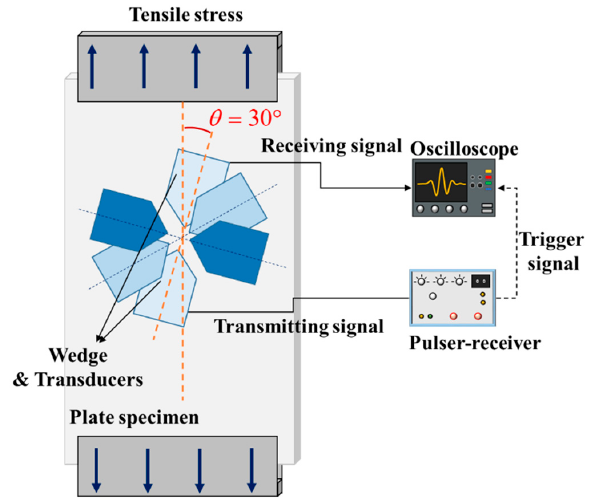
Figure 13. Experimental set-up for the proposed stress estimation.